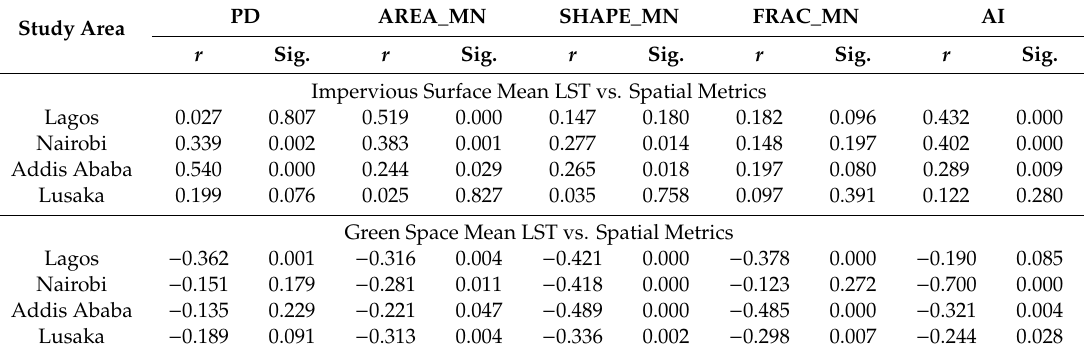
Table 3. Correlations between mean LST and selected urban landscape